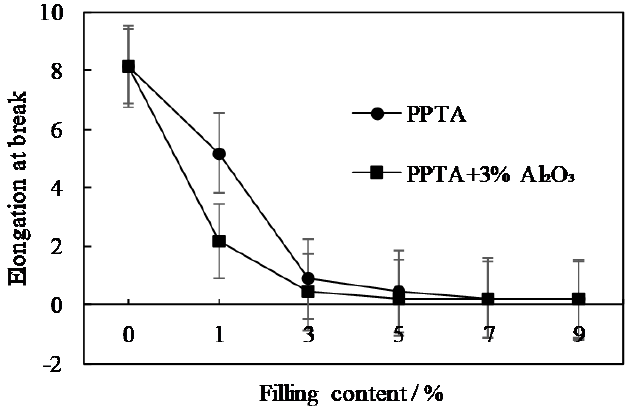
Figure 18. Tensile elongation at break of PPTA and nano Al 2 O3 filled modified PTFE composites.